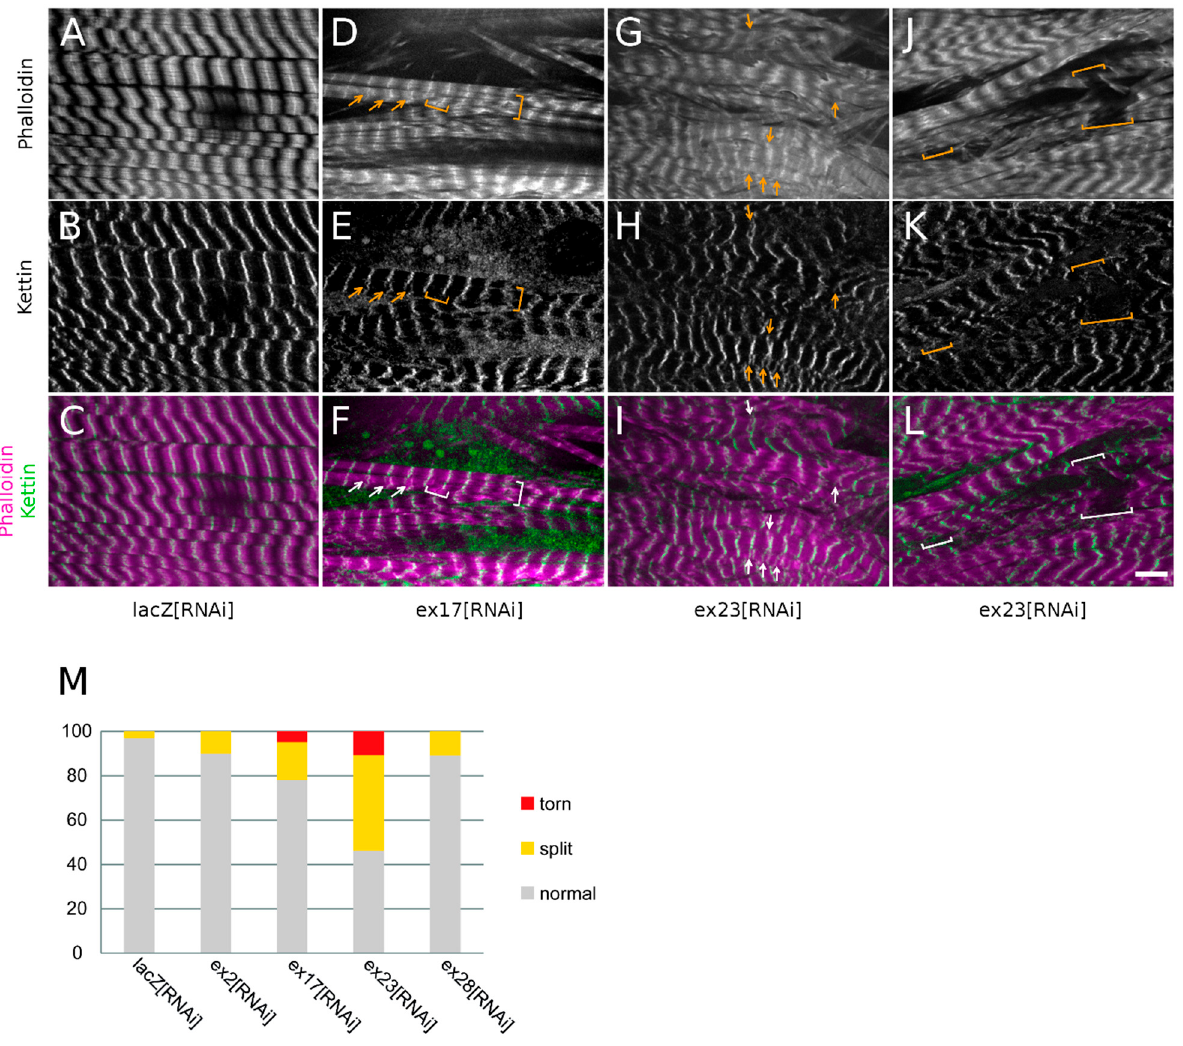
Figure 6. Depletion of CH containing Msp300 isoforms with ex17[RNAi] or ex23[RNAi] results in Z-discs weakening. ( A – L ) Muscle 4 from larvae expressing Msp300-Venus protein-trap together with lacZ ( A – C ), ex17[RNAi] ( D – F ) or ex23[RNAi] ( G – L ) and showing the contractile apparatus organisation. phalloidin labelling in grey ( A , D , G , J ) or magenta ( C , F , I , L ) and Kettin immunostaining in grey ( B , E , H , K ) or green ( C , F , I , L ). In addition to important disorganisation of the myofibrils, ex23[RNAi], and to a lesser extent ex17[RNAi], lead to splittings of the Z-discs (arrows in ( D – I )) as well as ruptures of myofibrils (brackets in ( D – F ) and ( J – L )). These ruptures occur at Z-discs, suggesting that CH+ Msp300 isoform depletion weakens Z-discs’ cohesion. ( M ) Quantification of Z-disc defects following Msp300[RNAi]. Scale bar: 10 µm.